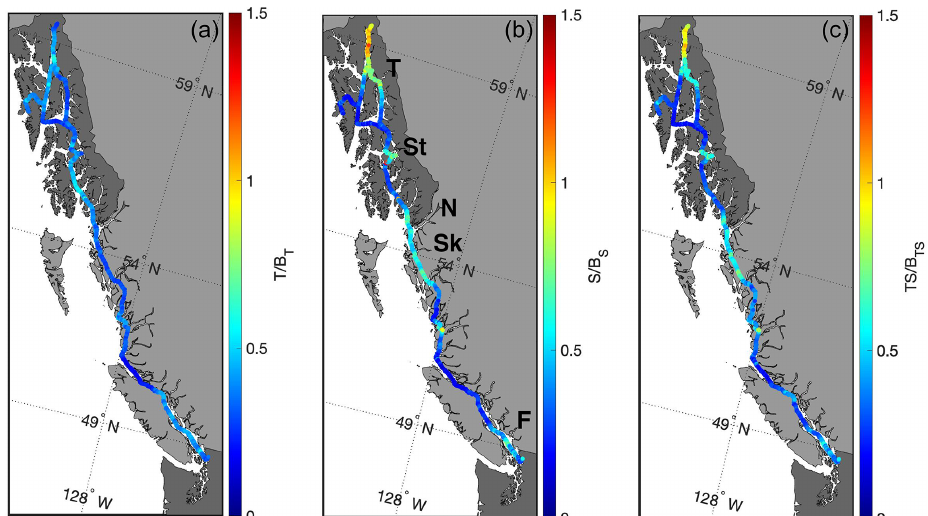
Figure 5. Ratios of the seasonal amplitudes of thermodynamic and biophysical drivers of p CO 2 variability. (a) The ratio of the amplitude of the temperature component ( T ) to the amplitude of the remaining biophysical components ( B T ). (b) The ratio of the amplitude of the salinity component ( S ) to the amplitude of the remaining biophysical components ( B S ). Areas with major river outflows are highlighted in this panel (Taku River (T), Stikine River (St), Nass River (N), Skeena River (Sk), and the Fraser River (F)). (c) The ratio of the amplitude of the combined temperature and salinity components ( T S ) to the amplitude of the remaining biophysical components ( B TS